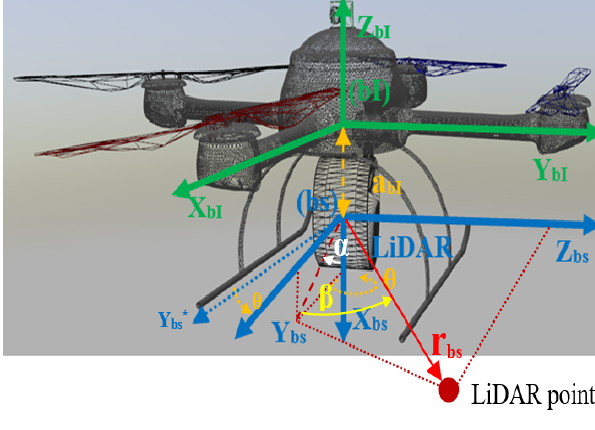
Figure 1. The sensor configuration with reference frames